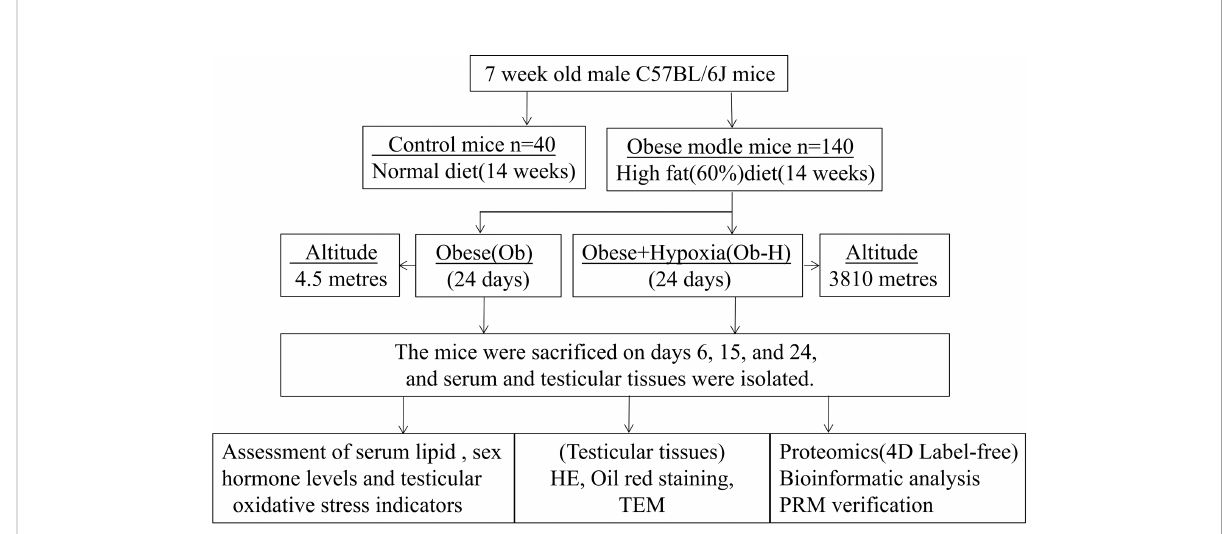
FIGURE 1 Flow chart of the experimental